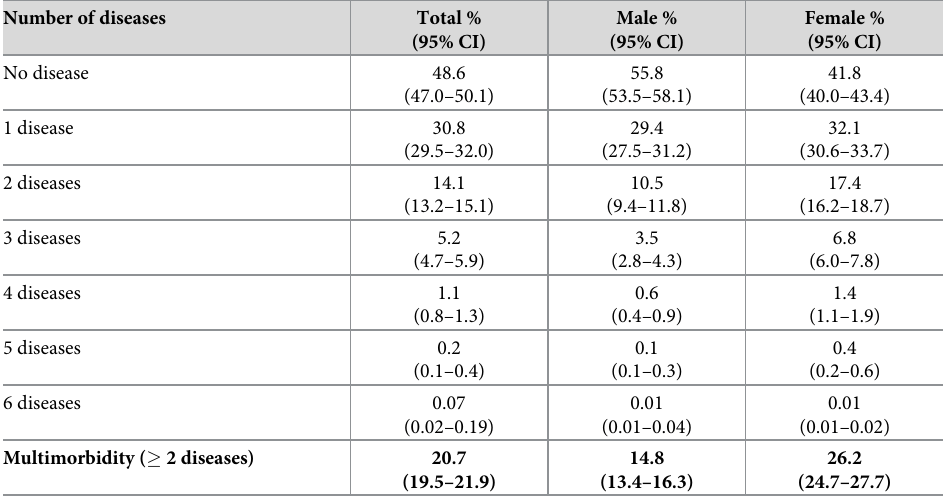
Table 5. Number of diseases in individuals by sex in South Africa for 2016 (weighted data).